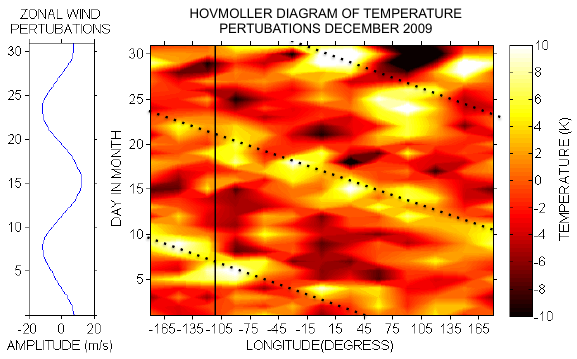
Fig. 8. On the right of the figure is the Hovm¨oller diagram of the the right of the figure is the Hovm ¨ o ller diagram of the Aura MLS temperature data in Fig. 8. On Aura MLS temperature data in 30 ◦ longitude bands for the month of December in 2009, at 40–45 ◦ N and ∼ 90km. The black line 30 ◦ longitude bands for the month of December in 2009, at 40 – 45 ◦ N and ∼ 90 km. The black shows the approximate location of BLO and the dashed line the line shows the approximate location of BLO and the dashed line the wave phase fronts. On wave phase fronts. On the left is the band-passed 16-day wave radar the left is the band-passed 16-day wave radar zonal winds for the same time and approximate zonal winds for the same time and approximate height. height.